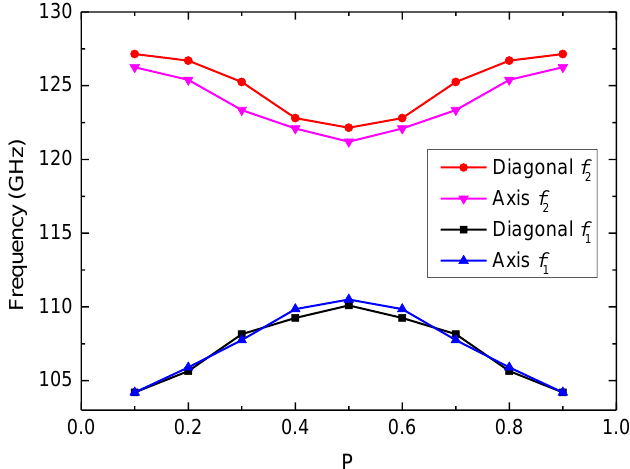
Figure 5. Resonant frequencies for various misalignments in the axial and diagonal directions.